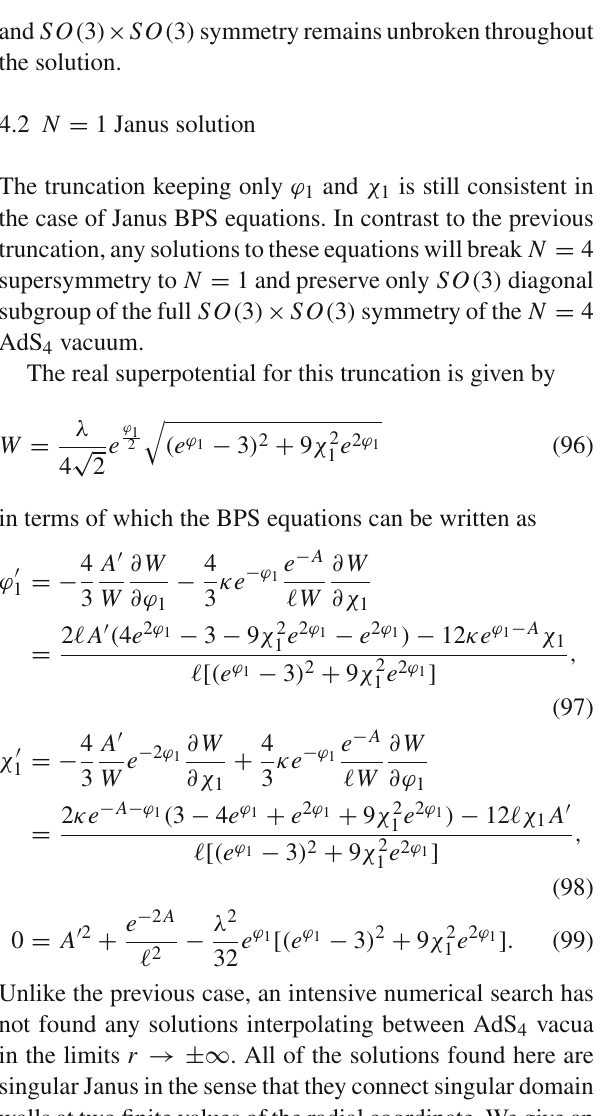
and SO ( 3 ) × SO ( 3 ) symmetry remains unbroken throughout the